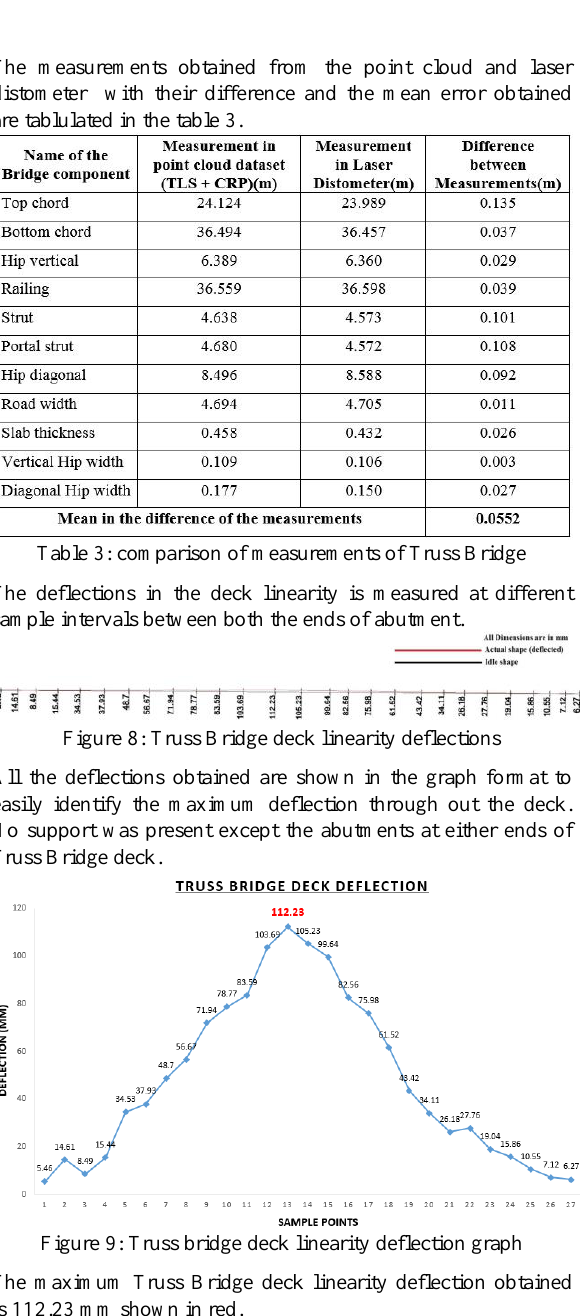
Figure 14: Beam Bridge deck linearity deflections